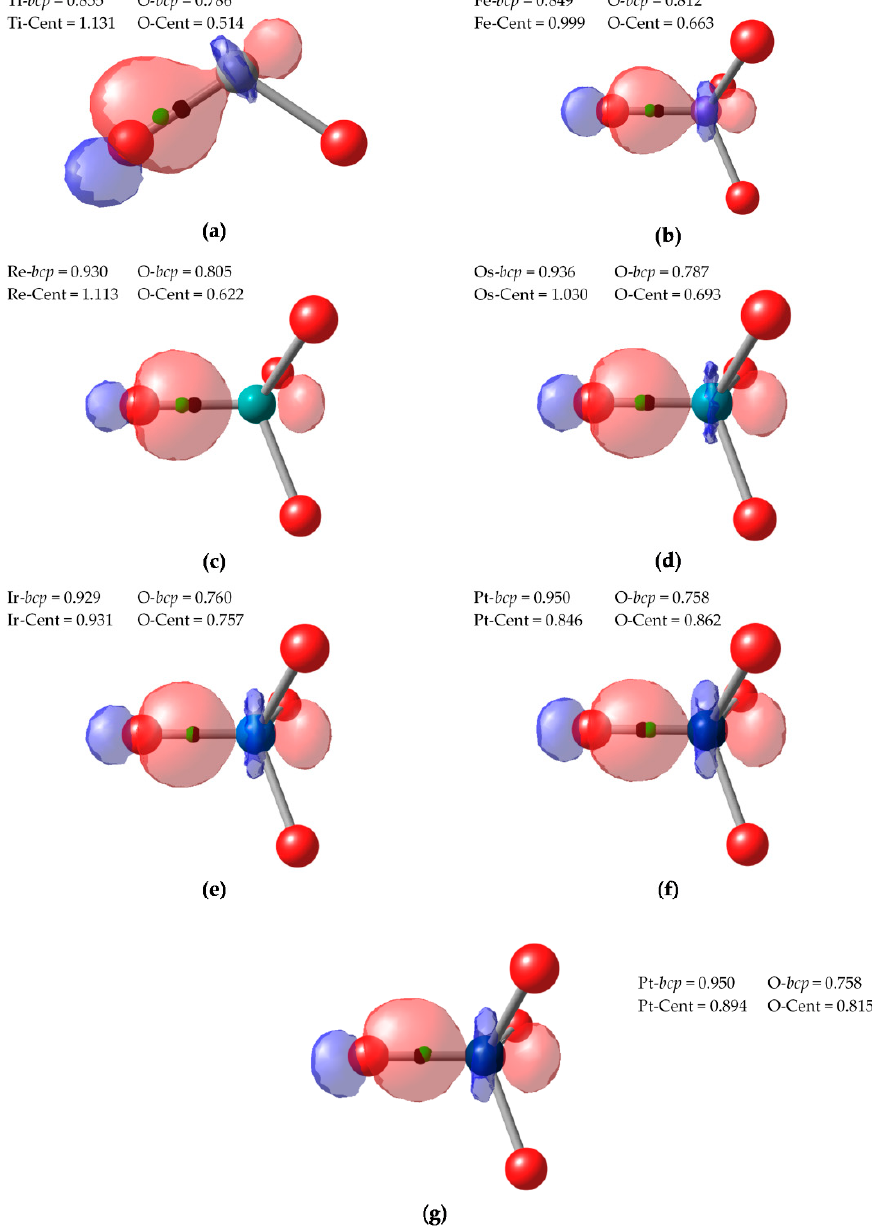
( e ) and PtO 42 + ( f , g ). bcp and centroid represented by black and green dots, respectively. (distances in